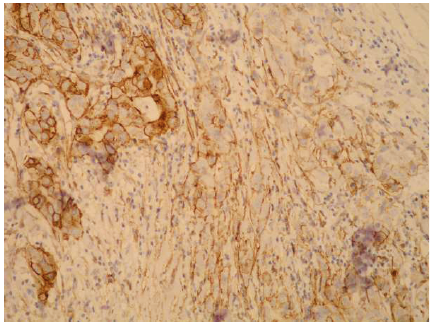
Figure 6: Strong epithelial (both membranous and cytoplasmic) Sdc1 expression in the IDC metastasis in the axillary lymph node (IHC, × 200).